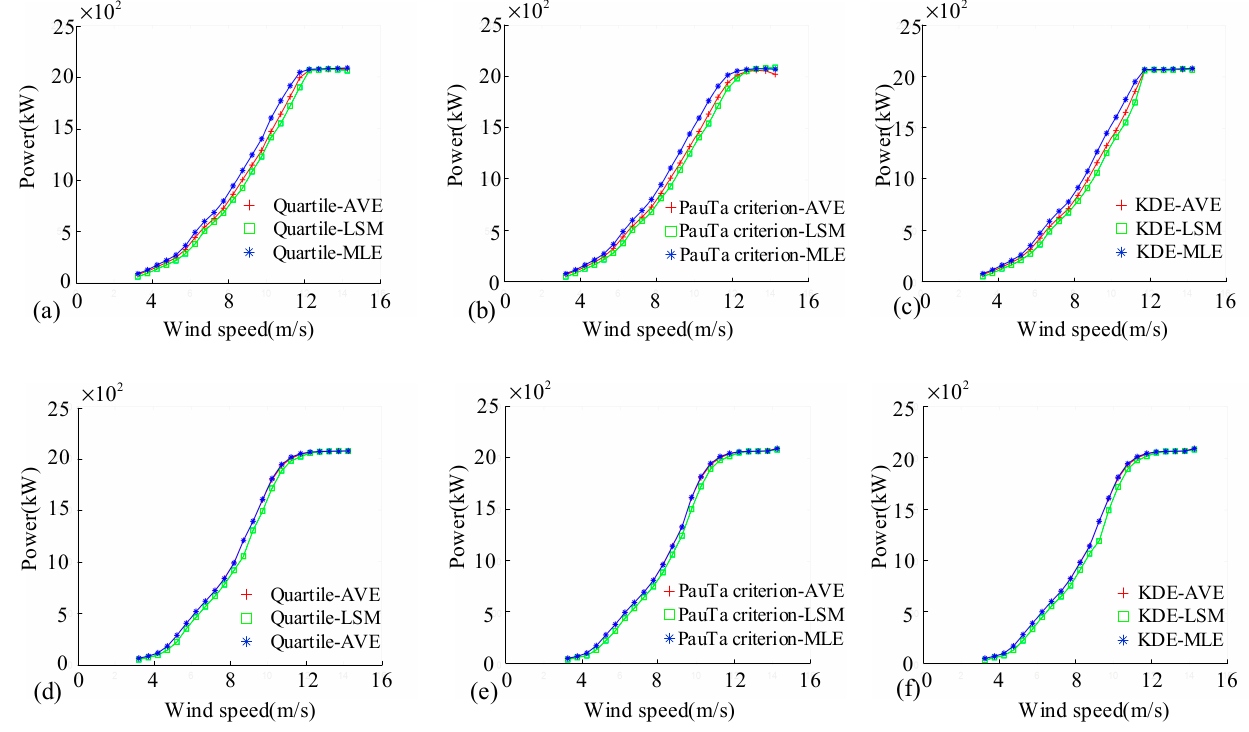
Figure 9. Influence of Binning benchmark on wind-power curve. ( a ) wind-power curves obtained by binning wind speed data using three Quartile-based methods; ( b ) wind-power curves obtained by binning wind speed data using three PauTa-based methods; ( c ) wind-power curves obtained by binning wind speed data using three KDE-based methods. ( d ) wind-power curves obtained by binning power data using three Quartile-based methods. ( e ) wind-power curves obtained by binning power data using three PauTa-based methods. ( f ) wind-power curves obtained by binning power data using three KDE-based methods. Table 3. Indicators of two kinds of data Binning benchmarks.